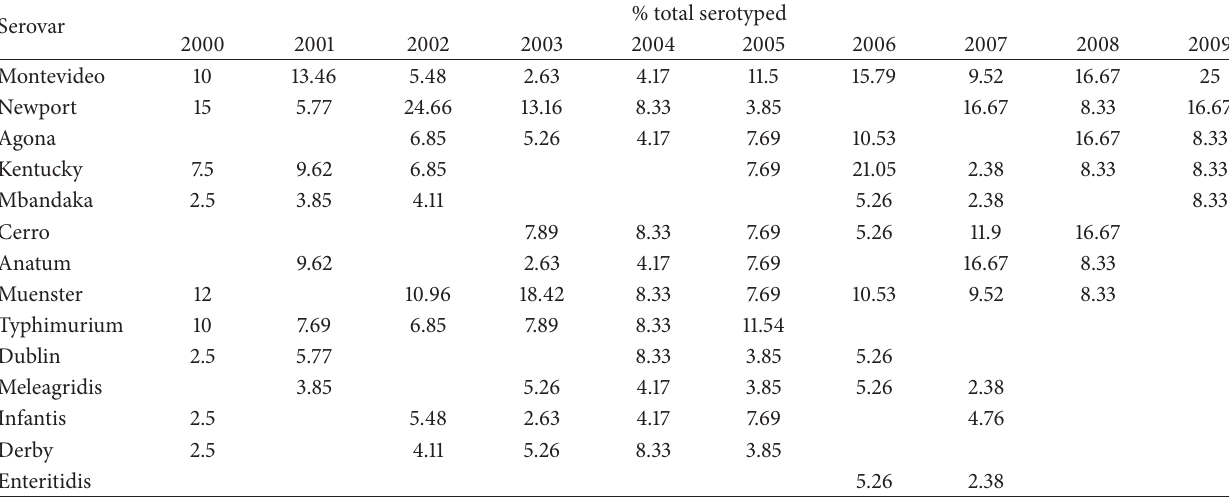
Table 10: Examples of Salmonella serovars profiles from cows and bulls in the US [36]. Serovar